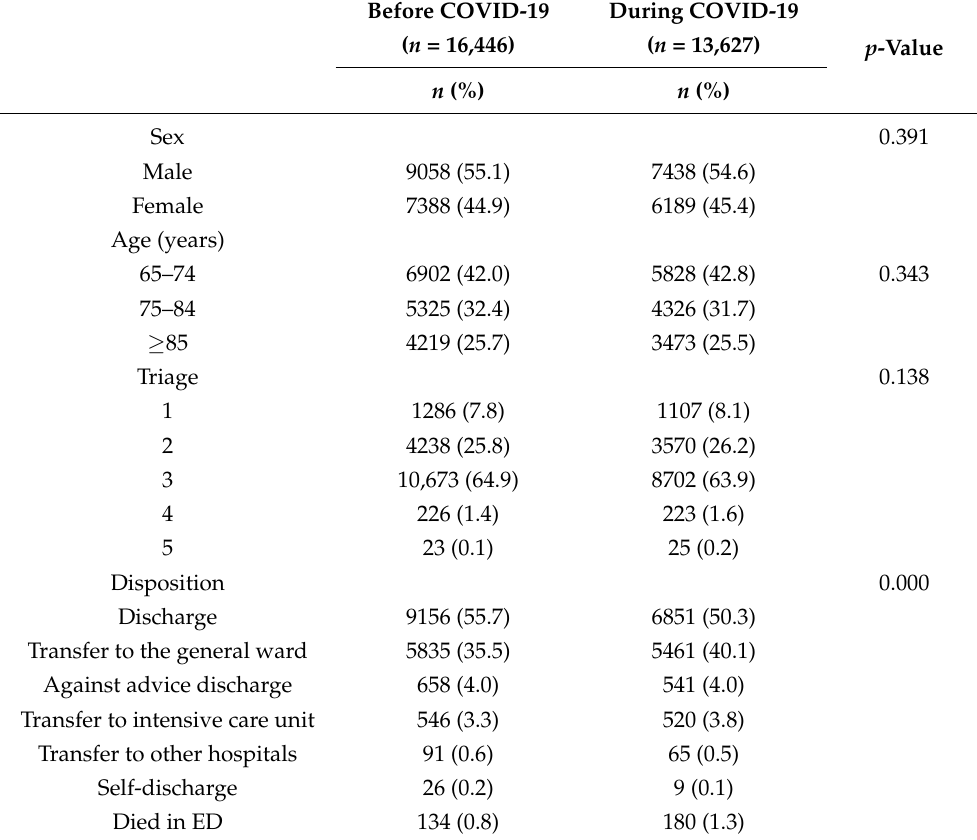
Table 1. Comparison of the characteristics of elderly patients in emergency department (ED) during the COVID-19 pandemic versus during the pre-pandemic period. Before COVID-19 During COVID-19